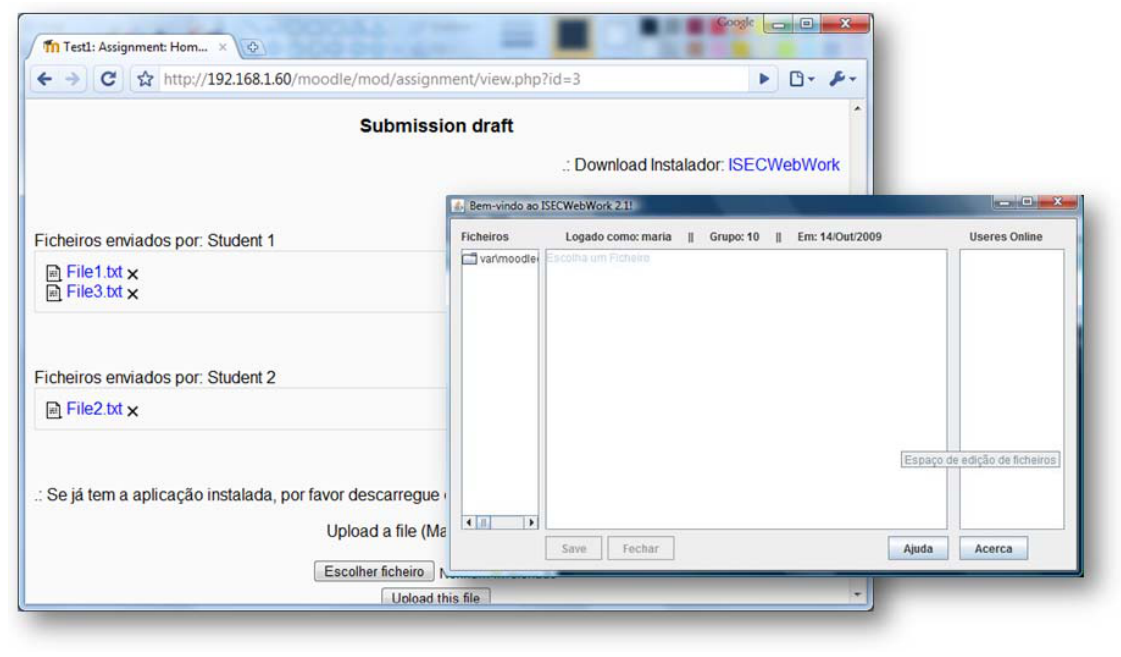
Figure 7. New assignment